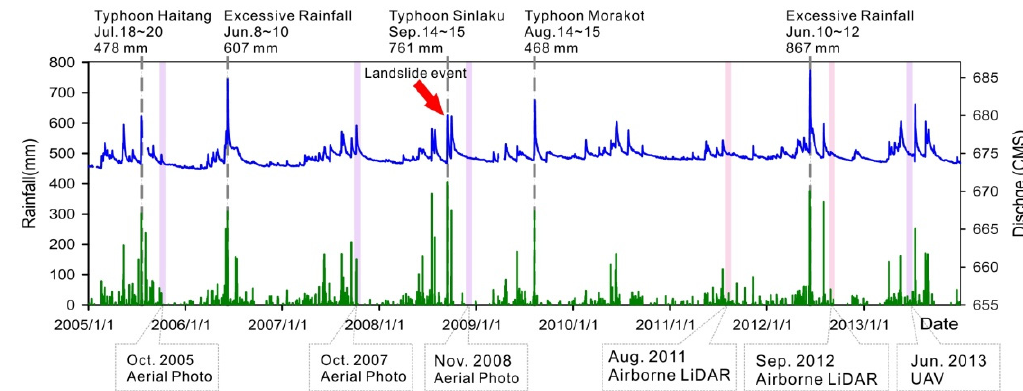
Figure 3. The green bars show the rainfall data recorded by the Qingliu rainfall monitoring station from 2005 to 2013. The blue lines are the flowrate data measured in Beigang River, and the dash lines representing typhoon and torrential rain incidents during this period of time. The purple lines indicate the times when aerial photography and ALS measurements were conducted in this study.